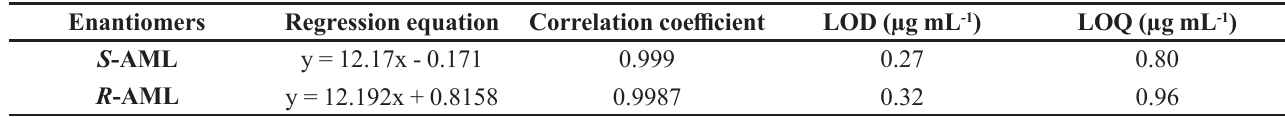
TABLE IV - Calibration data and LOD/LOQ values for AML chiral separation (concentration range: 5-100 µg mL -1 , n = 3, n = 3) Enantiomers